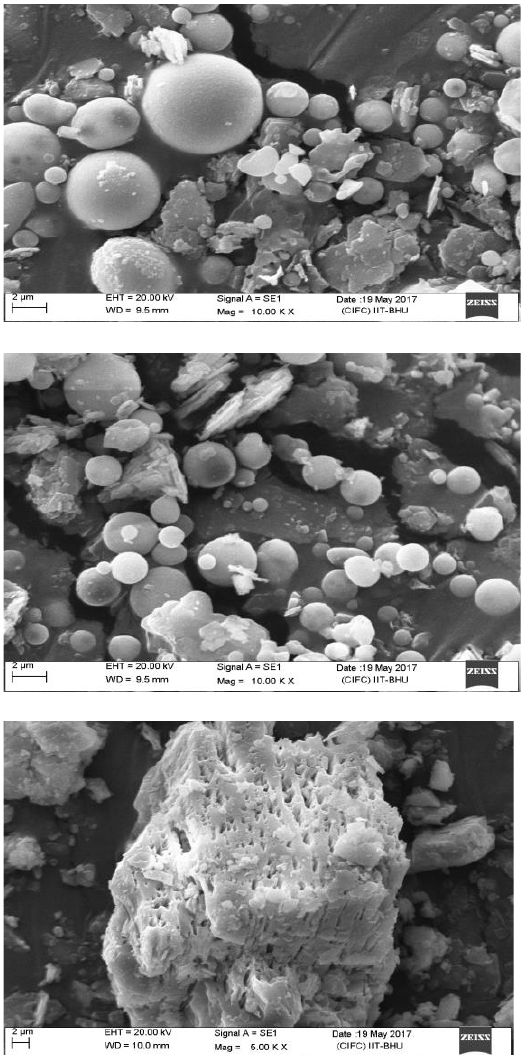
Figure 4. SEM images (2 μm) of fly ashes from Anpara, Shaktinagar, Renusagar and Vindhyachal TPPs.